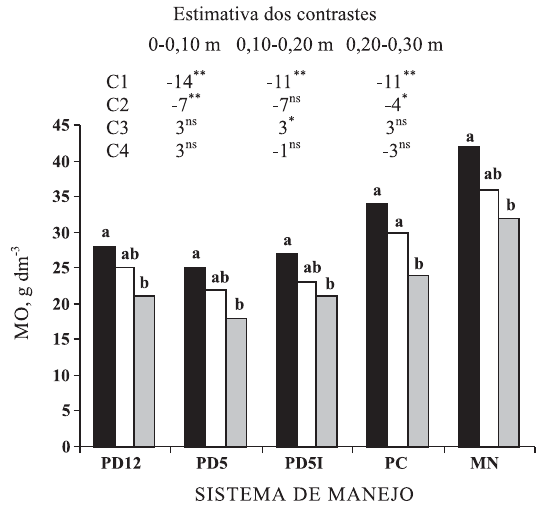
Figura 1. Teores de matéria orgânica (MO) e estimativa dos contrastes estabelecidos para os cinco tratamentos e três profundidades. Camada de 0–0,10 m ( ); 0,10–0,20 m ( ); 0,20–0,30m ( );